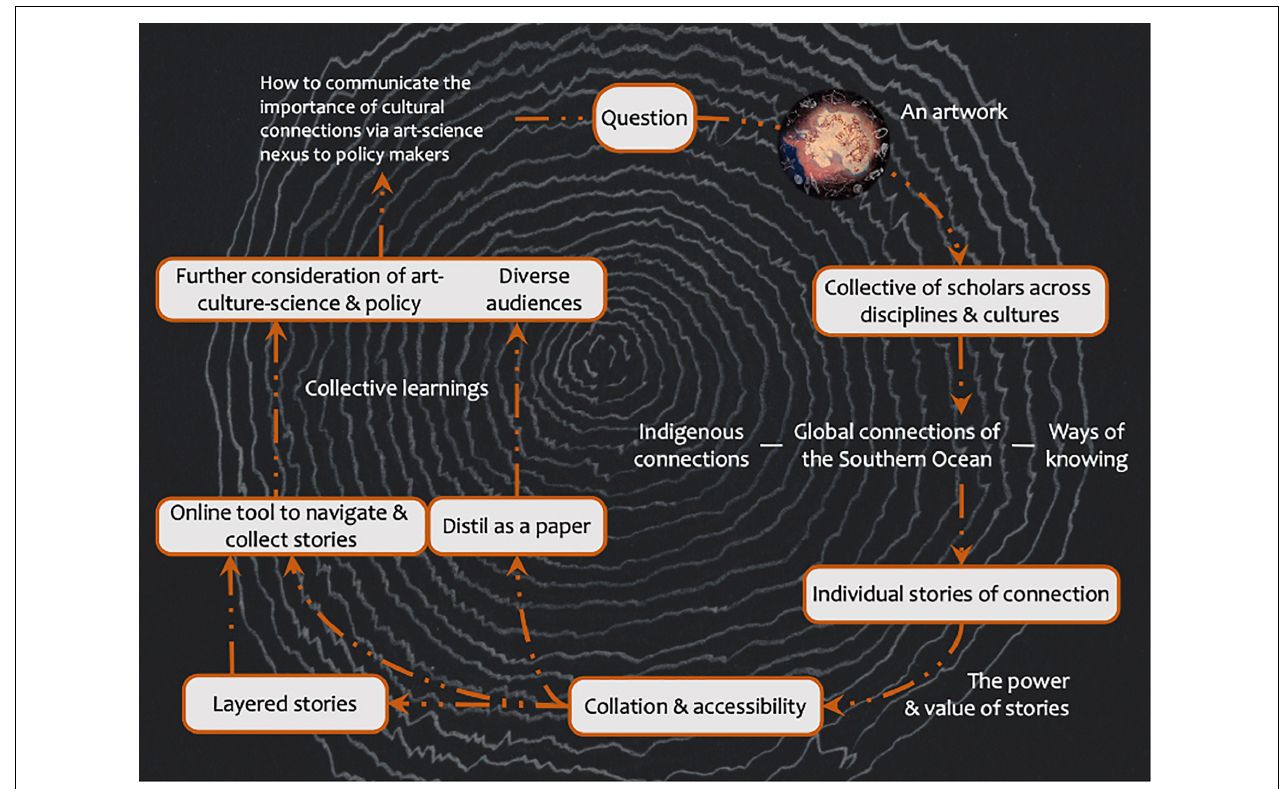
FIGURE 2 | Process used to develop this perspective based on the question of how to communicate to policy-makers the importance of cultural connections with the Southern Ocean, and the emerging values for the region, via art-science